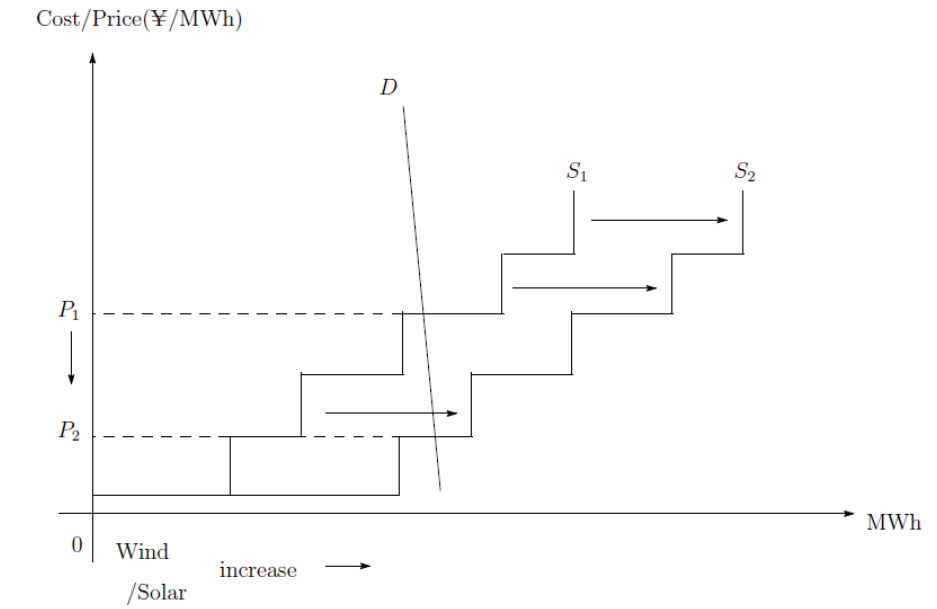
Figure 4. The Price Effect of Increasing Renewable